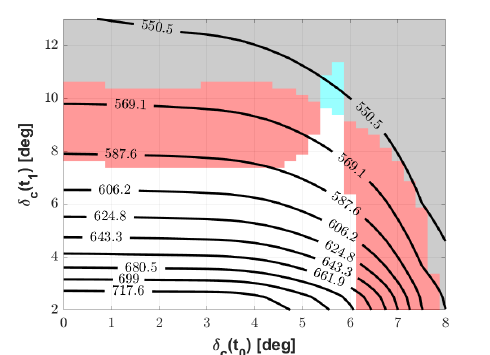
Figure 10. Example partial cost function analysis for a three-surface aircraft. Change of D TO with δ c ( t 0 ) and δ c ( t 1 ) . Assigned δ e ( t 0 ) = δ e ( t 1 ) = − 2 deg, and control pull-up speed V ( t 1 ) = 41 m/s. Red area: tail strike. Cyan area: take-off before control pull-up. Grey area: two or more constraints